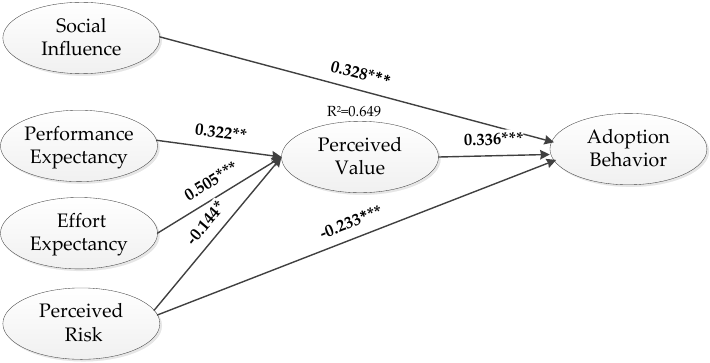
Figure A1. The results of the alternative model. Note: *** p < 0.001; * p < 0.05.